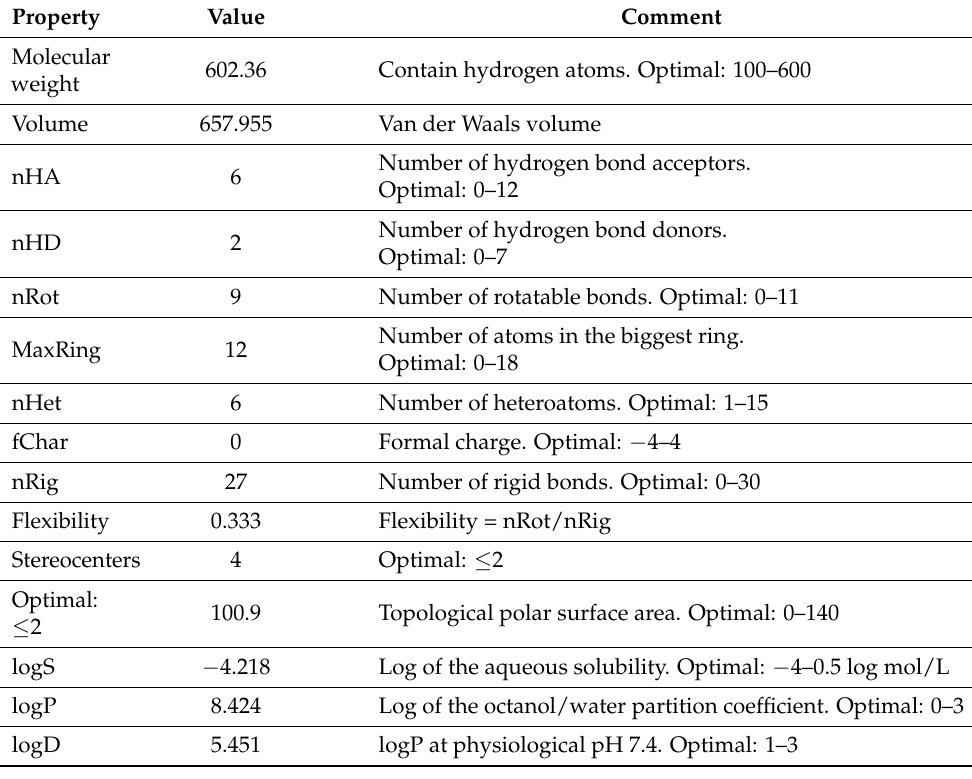
Table 6. Physicochemical properties of compound 1